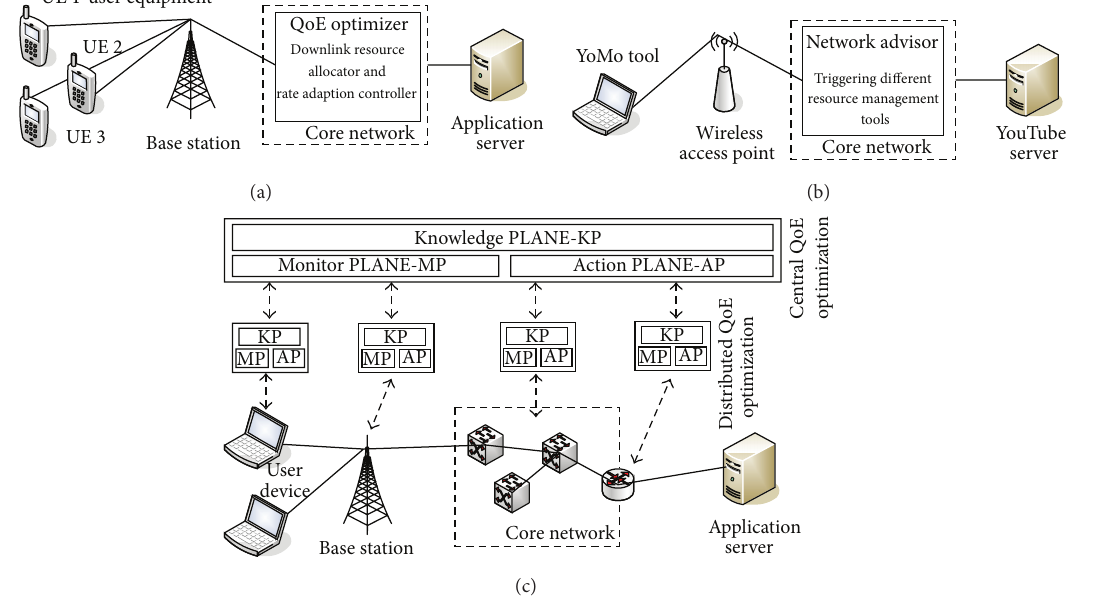
Figure 6: QoE optimization mechanisms: (a) Thakolsri et al. [103]; (b) Staehle et al. [97]; (c) Latr´e et al.